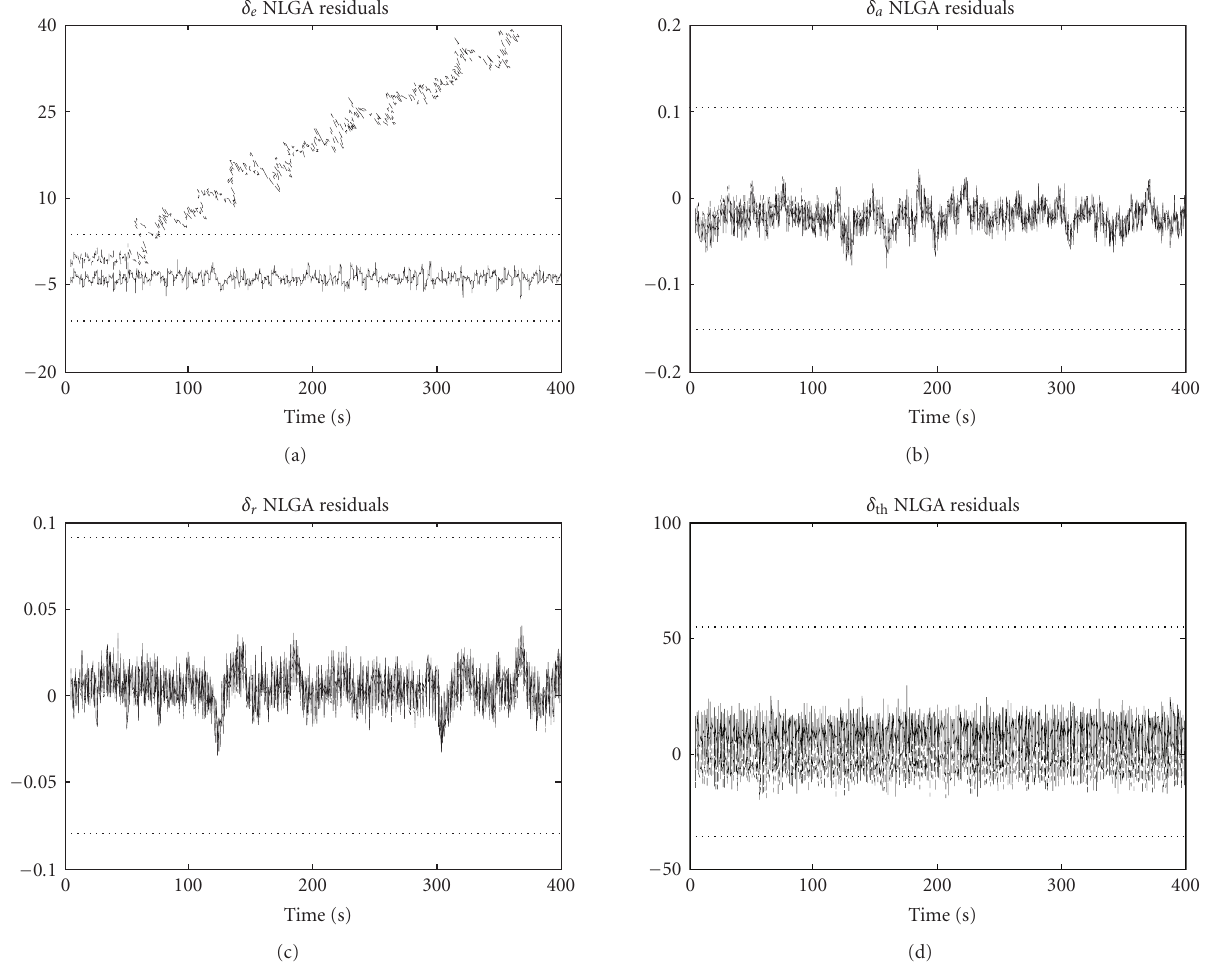
Figure 2: NLGA residuals for the 1st input sensor fault isolation with ν =